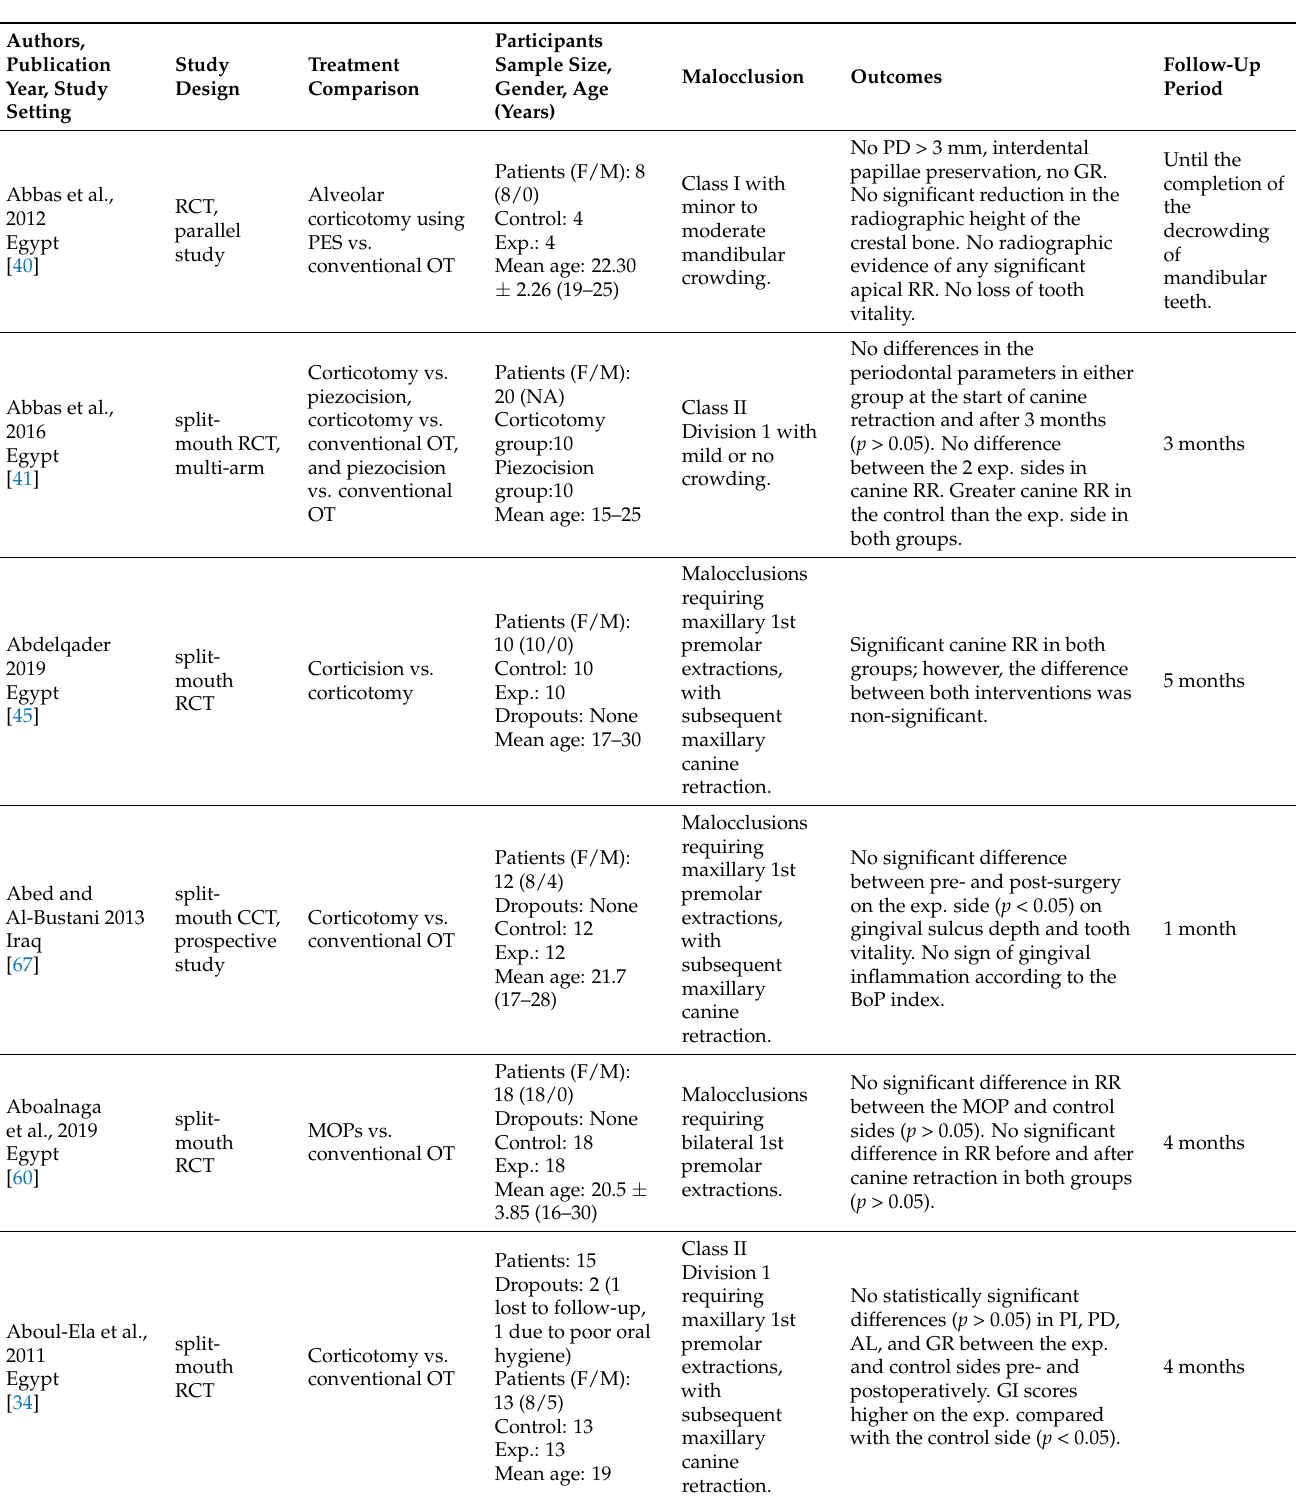
Table A1. Characteristics of included studies in the systematic